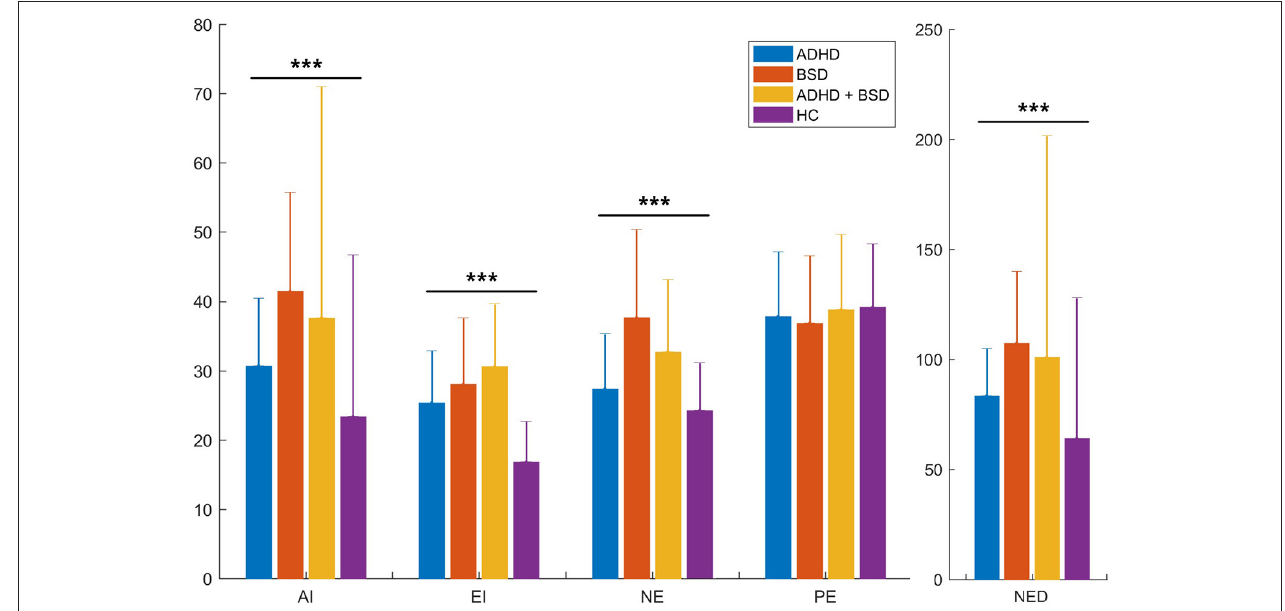
FIGURE 1 | RIPoSt-40 subscales: comparisons between clinical and non-clinical groups. Scores obtained by the four groups in our sample, namely the three clinical groups and the control group, in the five RIPoSt-40 questionnaire subscales—AI, EI, NE, PE, and NED—are here illustrated. Scores are compared between ADHD patients (blue bars), BSD patients (red bars), comorbid ADHD + BSD patients (yellow bars), and HC individuals (purple bars). Graphs represent means with standard deviation bars. ADHD, attention deficit hyperactivity disorder; AI, affective instability; BSD, bipolar spectrum disorder; EI, emotional impulsivity; HC, healthy controls; NE, negative emotionality; NED, negative emotional dysregulation; PE, positive emotionality; RIPoSt-40, Reactivity, Intensity, Polarity and Stability questionnaire. *** p < 0.001.